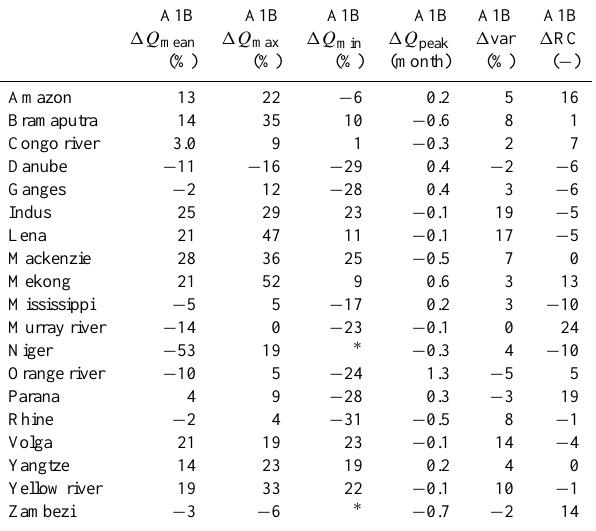
Table 4. Percentage change for the hydrological parameters of in- terest (see Table 3). Calculated for the A1B experiment, relative to the 20C3M